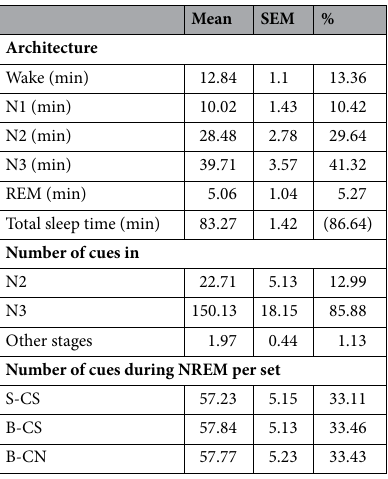
Table 2. Sleep architecture and cuing during